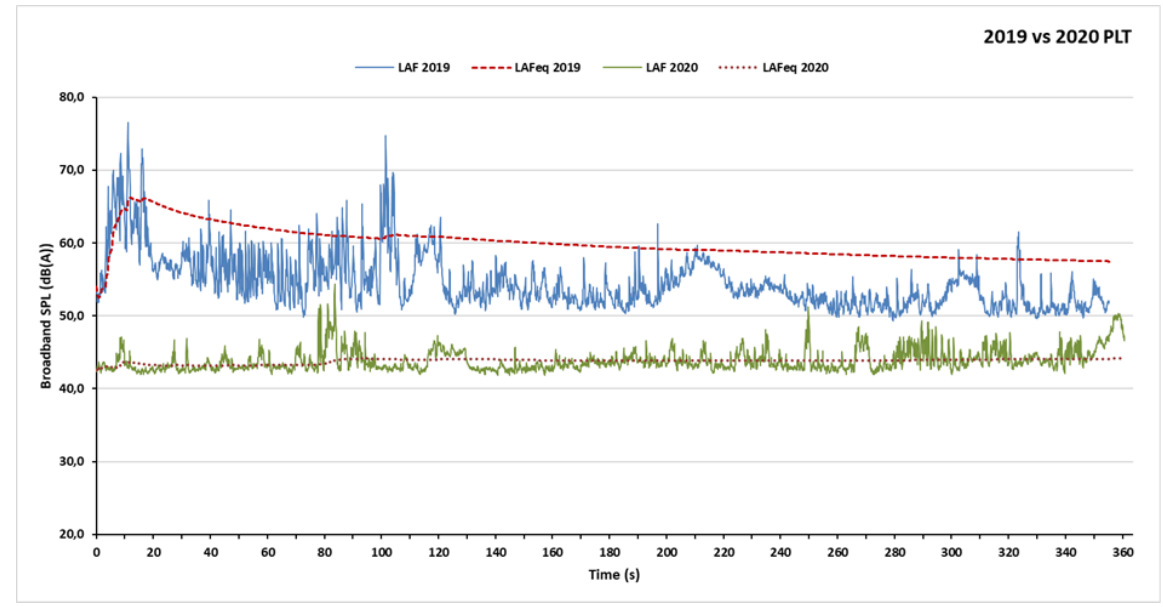
Figure 11: Broadband sound pressure levels in 2019 and during the lockdown in 2020 for the six minutes period recording together with the equivalent noise level at site no. 2